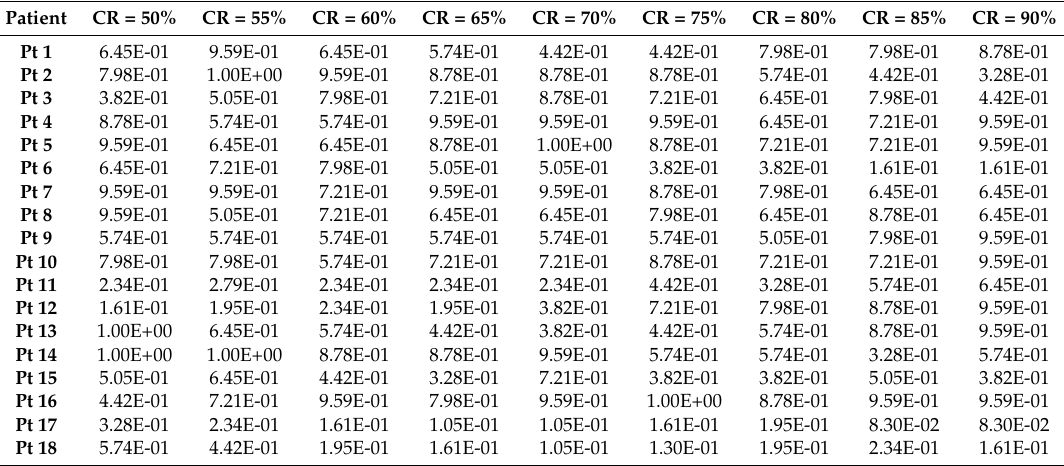
Statistical comparison ( p values) of the SSIM of the two hemispheres (analysis of Low-Density